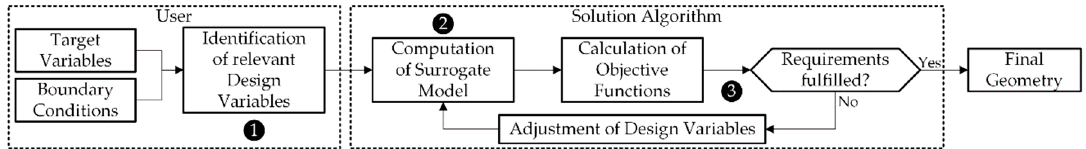
Figure 2. Deterministic method with surrogate model. Distinct properties are numbered and